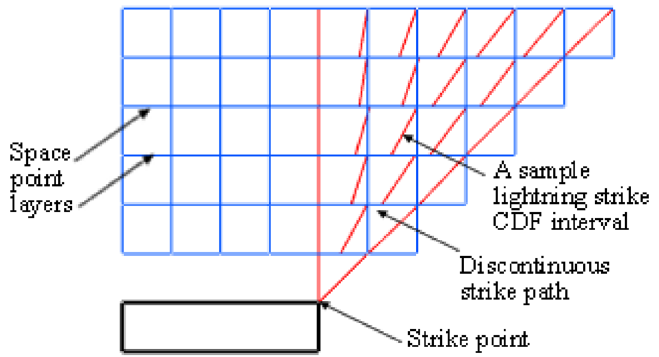
Figure 2. The discontinuous effect due to the vertical discretisation of space layers.